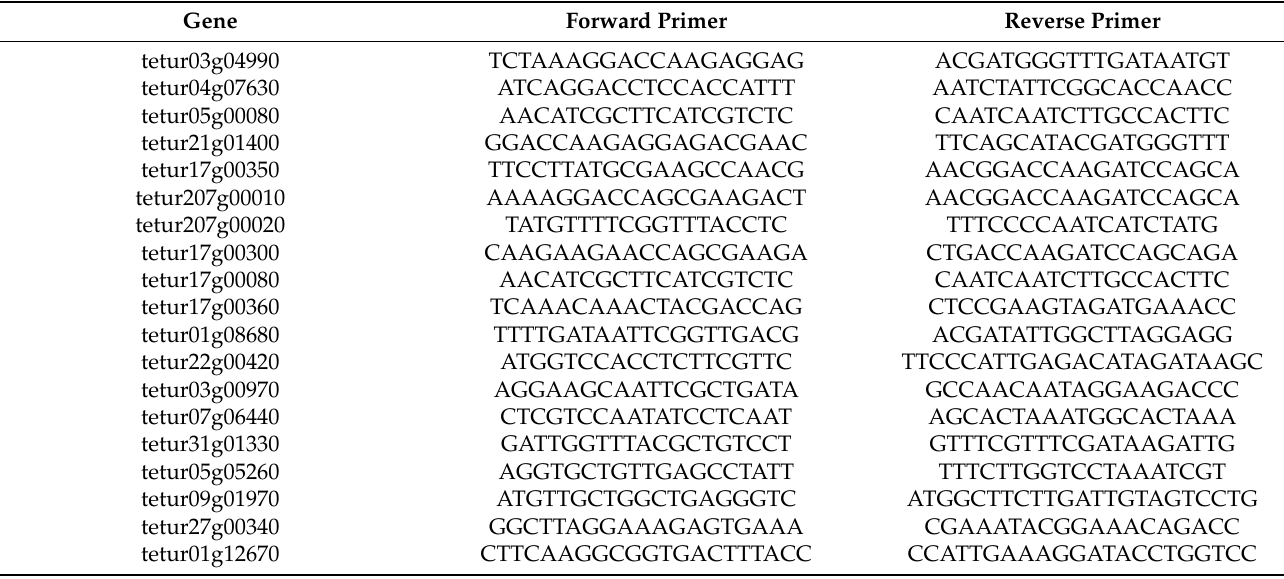
Table 4. qPCR primers of the selected